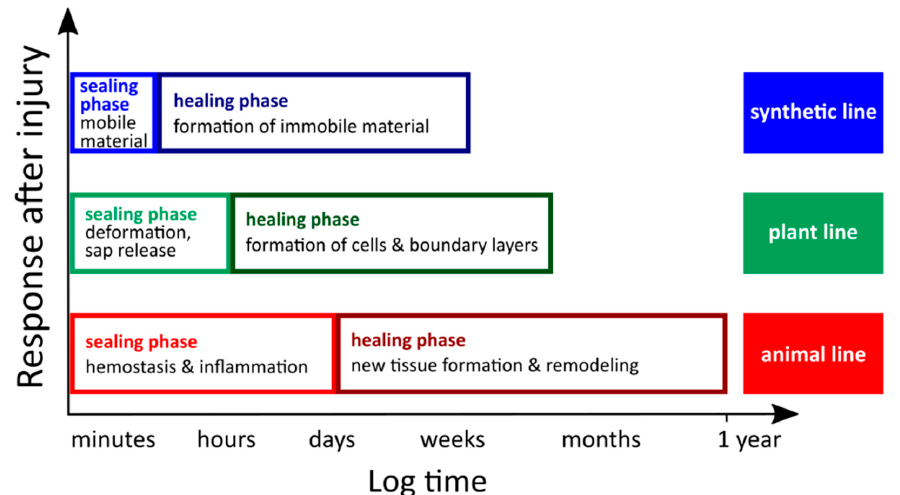
Figure 1. Comparative depiction of self-repairing phases in plants, animals and technical materials.